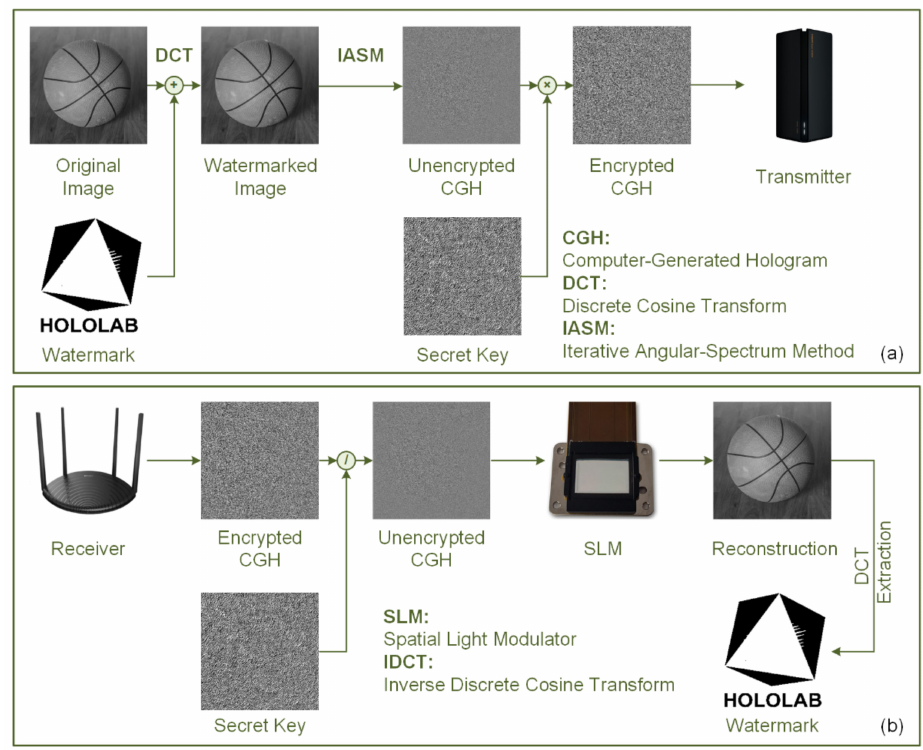
Figure 1. ( a ) The signal side and ( b ) the display side of the holographic communication system.